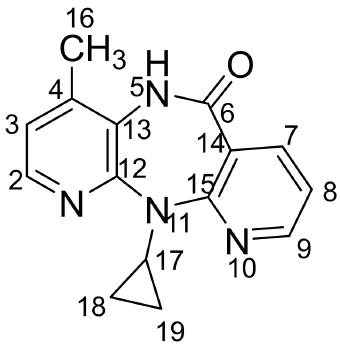
Figure 7. The structure of Nevirapine. Table 1. Predicted and experimental 13 C NMR chemical shifts (in ppm) of